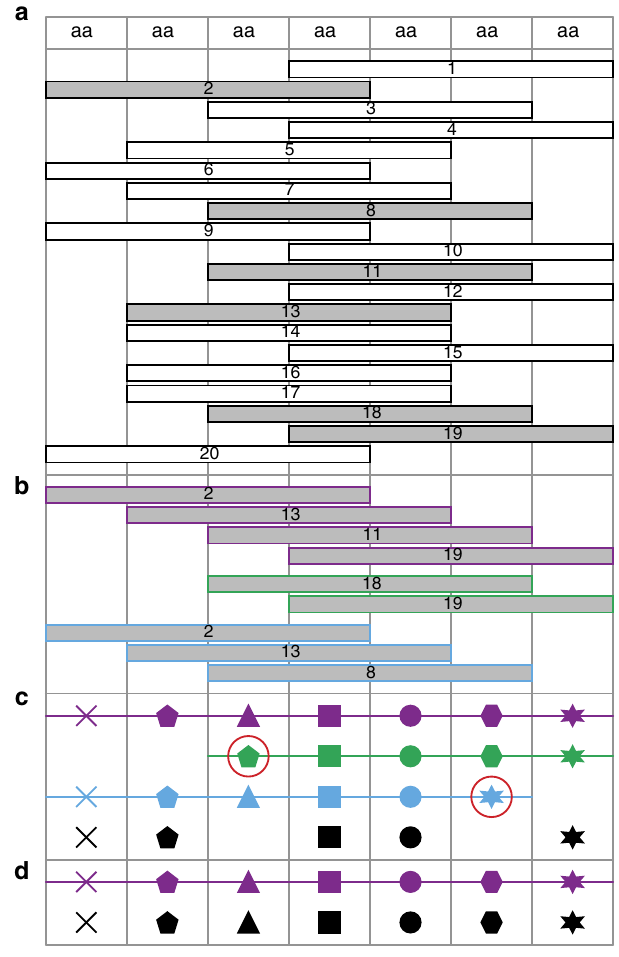
Fig. 2 Schematic representation of 4D-CHAINS decision making using Overlap Layout Consensus assembly. a Chains of AAIGs of given length L are translated to peptides and aligned to the query sequence. b Contigs of overlapping chains (overlap length L -1) are generated. Peptides that do not form contigs are discarded. c Contigs are lined up and absolute consensus AAIGs (shapes) are identi fi ed. If there is agreement with the associated con fi dence score (for details see Methods), then AAIGs are assigned to the corresponding amino acids of the sequence (black shapes). d Assigned AAIGs are restrained in next rounds of decision making. False peptides and contigs do not longer form and using the same rules additional AAIGs are assigned (triangle,